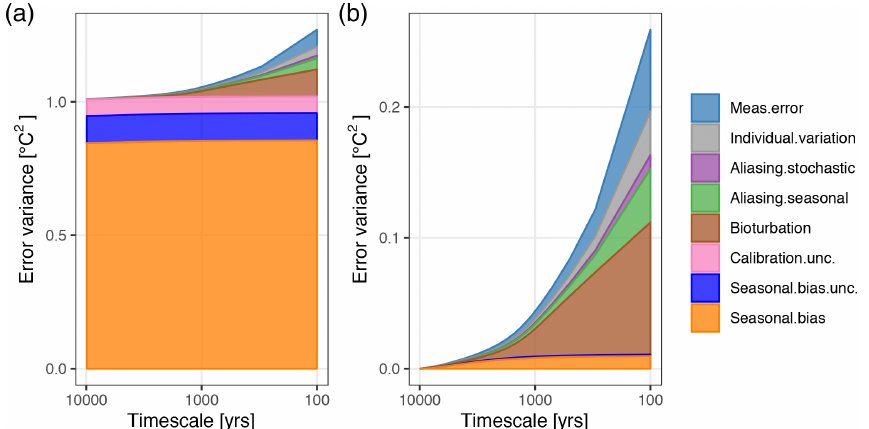
Figure 5. Timescale-dependent proxy error for an example parameter set. (a) Timescale-dependent error variance for all components of the spectral error model. (b) Timescale-dependent error variance for all components excluding those that manifest as constant errors that do not change with timescale, i.e., those originating as power at frequency